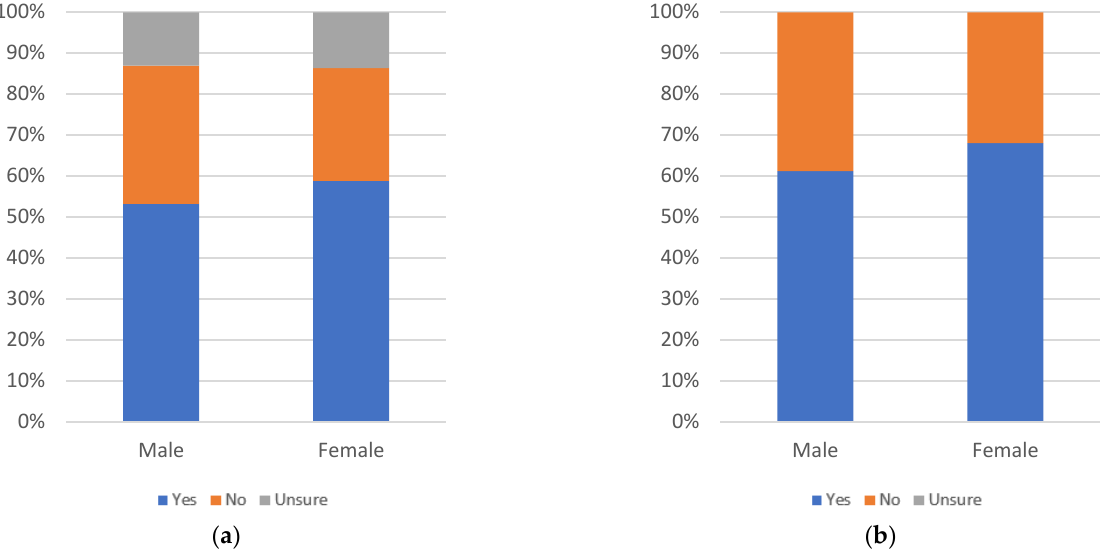
Figure 93. Label use, by gender: ( a ) with uncertain respondents (left) and ( b ) without uncertain respondents (right).